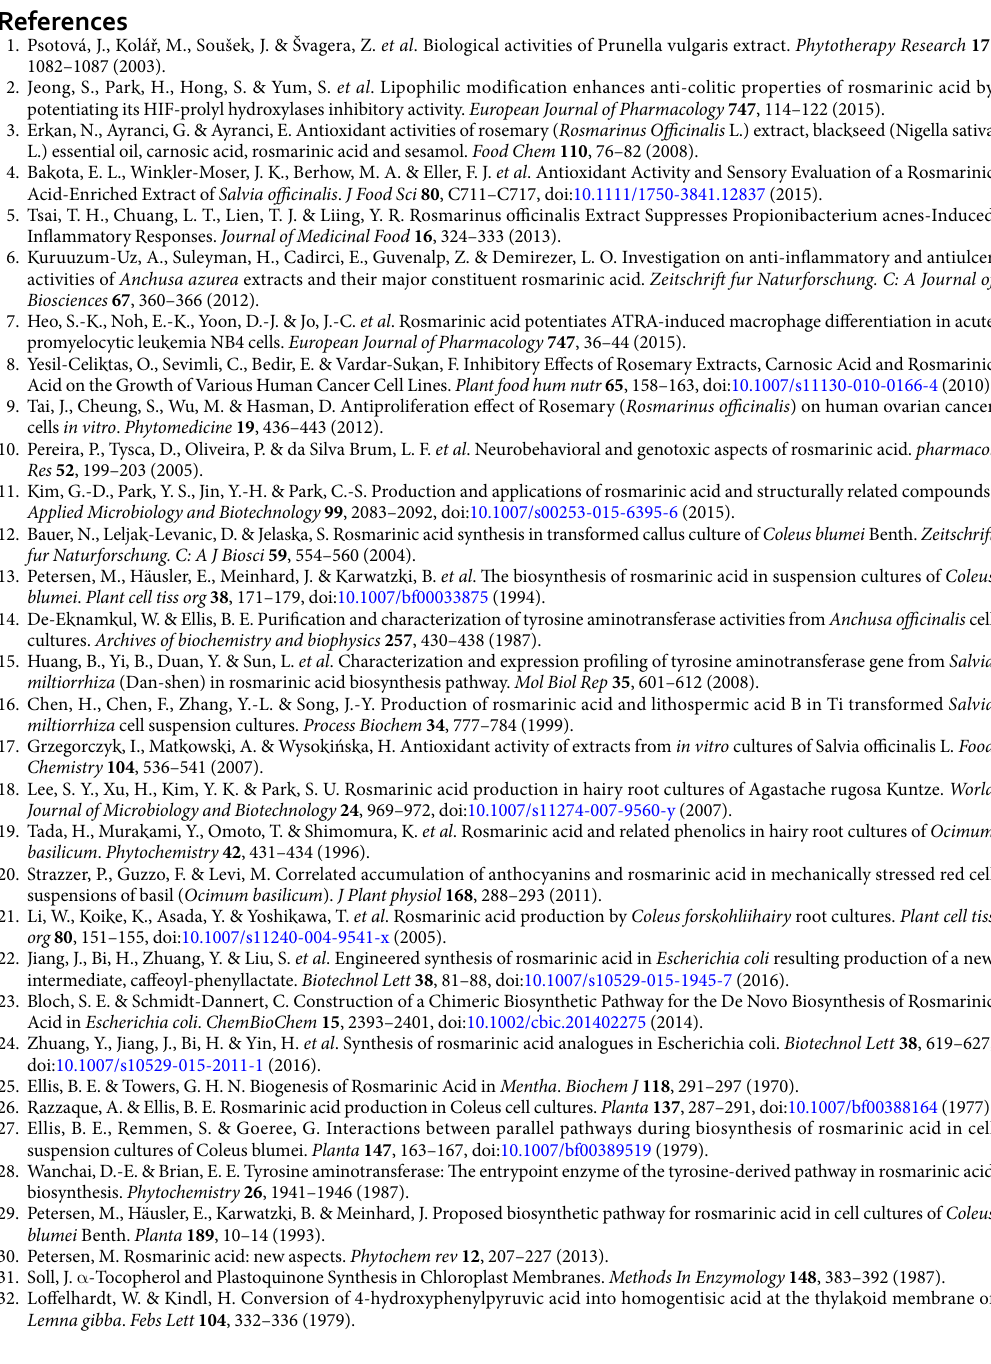
RA accumulation in wild-type hairy roots and transgenetic hairy root lines was assayed using HPLC according to our previous method 68 . Analysis for PvTAT gene